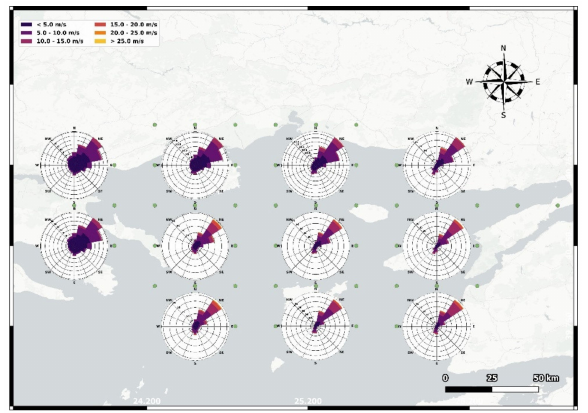
Figure 6. Wind frequency roses at hub height over the study